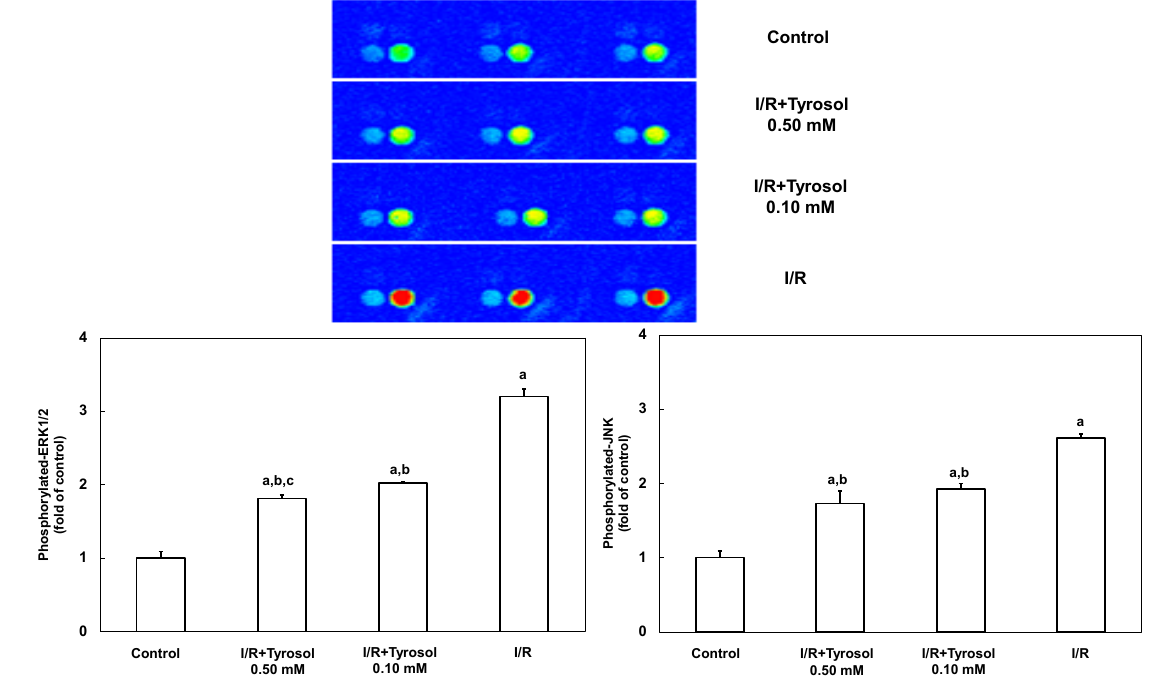
Figure 6. Effect of tyrosol on ERK and JNK activation in H9c2 cardiomyocytes during I/R. Cells were incubated with tyrosol (0.10 and 0.50 mM) before and during I/R. Phosphorylated-ERK and phosphorylated-JNK levels were determined using a MAP kinase phosphoprotein electrochemiluminescent sandwich ELISA assay. Sectoral images exhibiting chemiluminescence are shown, reflecting the levels of p-ERK and p-JNK in the samples. Left and right bright spots represent p-JNK and p-ERK, respectively. Results are expressed as fold that of control group and means ± SEs of the data of three independent experiments are shown. a: p < 0.05 compared with control, b: p < 0.05 compared with I/R cells, c: p < 0.05 compared with I/R + Tyrosol 0.10 mM